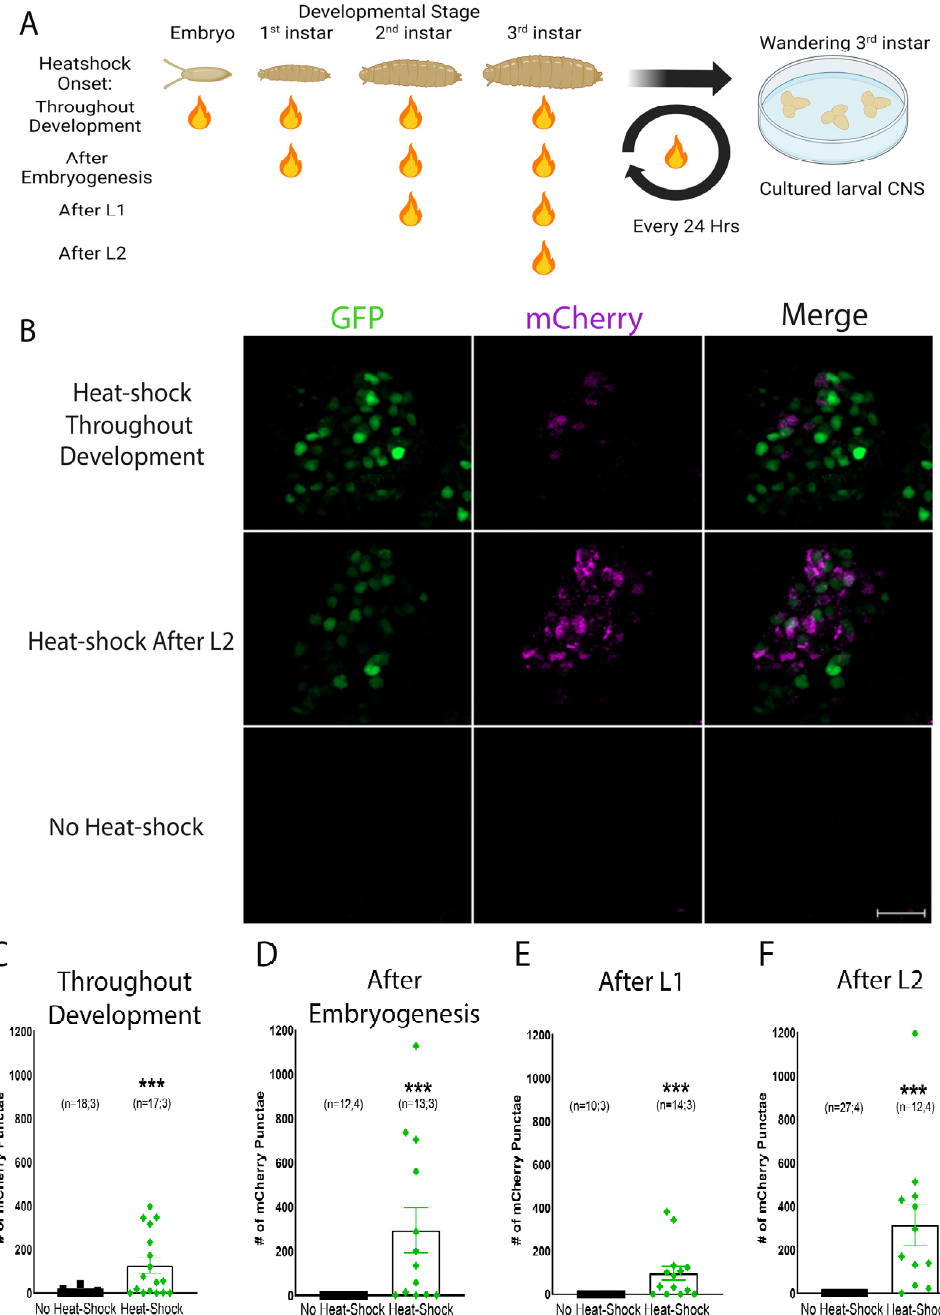
Figure 7. Activation of the sensor by endogenous molecules during larval development. ( A ) Schematic showing the heat-shock paradigm implemented during different stages of Drosophila development (image made with Biorender). ( B ) Repetitive heat-shock throughout Drosophila larval devel- opment (upper panels), or initiated after L2 (middle panels), induces sensor expression (GFP) in larval hemispheres, but not in the absence of heat-shock (lower panels). Despite the absence of any exposure to exogenous retinoids, significant transcriptional activation (mCherry expression) is ob- served in larval CNS hemispheres, after heat-shock throughout development and when heat- shocked after L2. ( C – F ) Quantification of the number of mCherry punctae indicates significant sen- sor activation occurred when heat-shocked throughout development ( C ), after embryogenesis ( D ), after L1 ( E ) or after L2 ( F ), compared to no heat-shock controls. Numbers in brackets represent total number of CNS and the number of separate trials. *** p ≤ 0.001 compared to no heat-shock controls. Scale bar: 50 μ m. Detection of sensor activity was quantified using the number of mCherry punctae (rather than the proportion of GFP punctae that contained mCherry), to allow comparison with their non-heat-shocked control counterparts. Representative images in Figure 7B il- lustrate that ligand sensor activation occurred when larvae were heat-shocked throughout development and also when heat-shocked after L2, though there was no mCherry expres- sion in control larvae that were not heat-shocked. A Mann-Whitney rank sum test re- vealed a significant increase in the number of mCherry punctae following heat-shock at each developmental stage ( p ≤ 0.001), compared to non-heat-shocked controls (Figure 7C– F). In order to rule out that prolonged heat-shock paradigms may have caused accumu- lation of sensor expression over time, GFP expression following heat-shock at different developmental stages was analyzed. A one-way ANOVA on ranks of the number of GFP punctae (H = 39.64; p < 0.001) and the GFP integrated density (H = 29.50; p < 0.001) revealed no significant differences in sensor expression (GFP) between CNS preparations that were heat-shocked at different stages of development (only differences compared to non-heat- shocked controls; Figure S2). Overall, these data suggest that there may indeed be nuclear signaling and transcrip- tional regulation mediated by retinoic acid or retinoid-like molecules during CNS devel- opment in Drosophila larvae. Furthermore, as these data indicate that LymRXR sensor ex- pression and activation occurred to a similar extent following heat-shock across any of the larval stages, endogenous retinoid activity might be occurring primarily during the 3rd instar larvae stage. 4. Discussion In this study, we generated a novel LymRXR ligand sensor fly line that reported both the expression and the transcriptional activity of the ligand sensor. This LymRXR ligand sensor system activated gene transcription in the presence of either 9- cis RA or all- trans RA as well as various synthetic retinoid agonists. It was also able to report the presence of possible endogenous retinoid signaling during Drosophila embryonic and/or larval